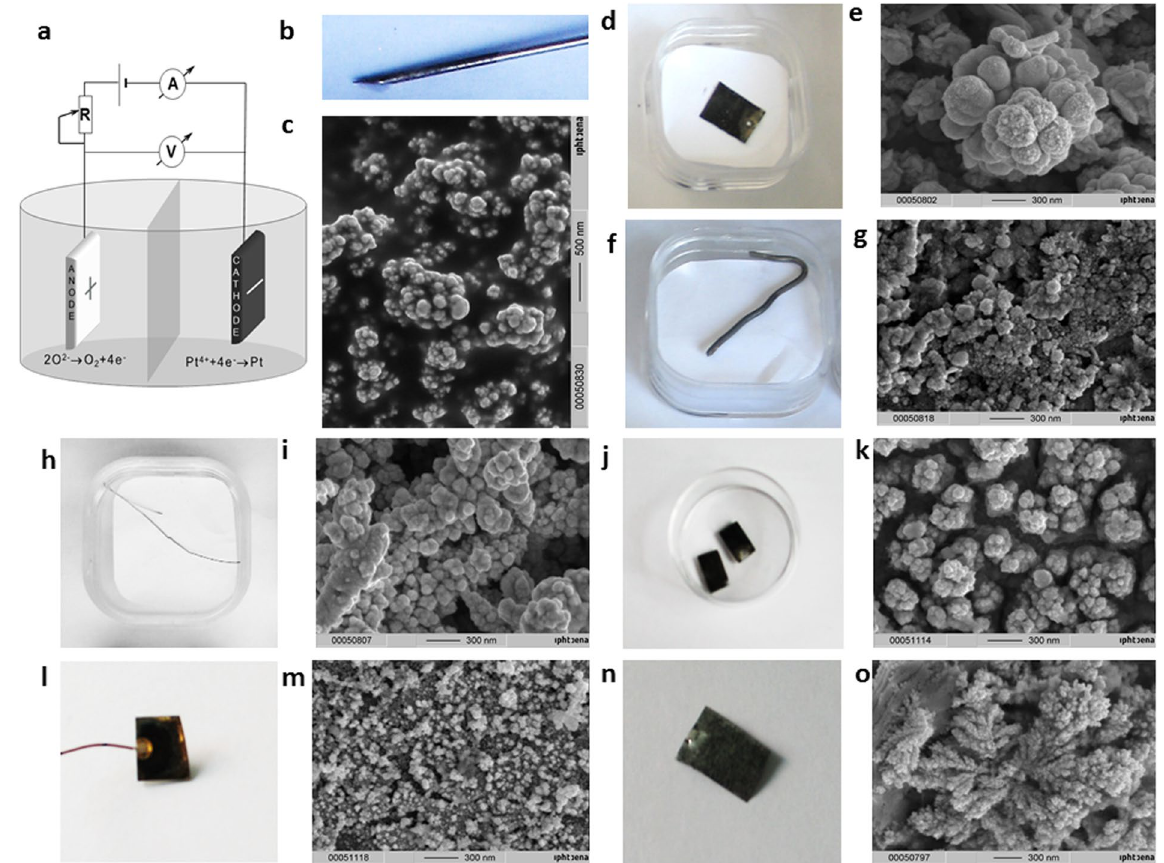
Figure 5. Electrochemically immobilized platinum black layer on different substrates. ( a ) The schematic representation of the electrochemical setup; ( b ) Photograph of the Pt on stainless steel substrate; ( c ) SEM image of the Pt on stainless steel indicated in ( b ); ( d ) Photograph of the Pt on Pt substrate; ( e ) SEM image of the Pt on Pt plate indicated in ( d ); ( f ) Photograph of the Pt on Ag substrate; ( g ) SEM image of the Pt on Ag indicated in ( f ); ( h ) Photograph of the Pt on Sn-Cu alloy substrate; ( i ) SEM image of the Pt on Sn-Cu alloy indicated in ( h ); ( j ) Photograph of the Pt on ITO substrate; ( k ) SEM image of the Pt on ITO indicated in ( j ); ( l ) Photograph of the Pt on Au substrate; ( m ) SEM image of the Pt on Au indicated in ( l ); ( n ) Photograph of the Pt on Al substrate; ( o ) SEM image of the Pt on Al indicated in ( n